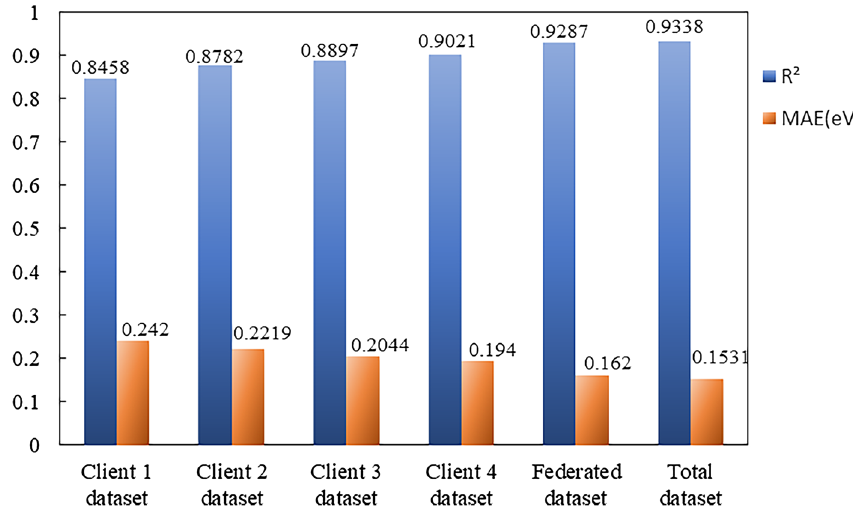
Figure 4. Column chart of shared model and individual trained model on each local dataset.